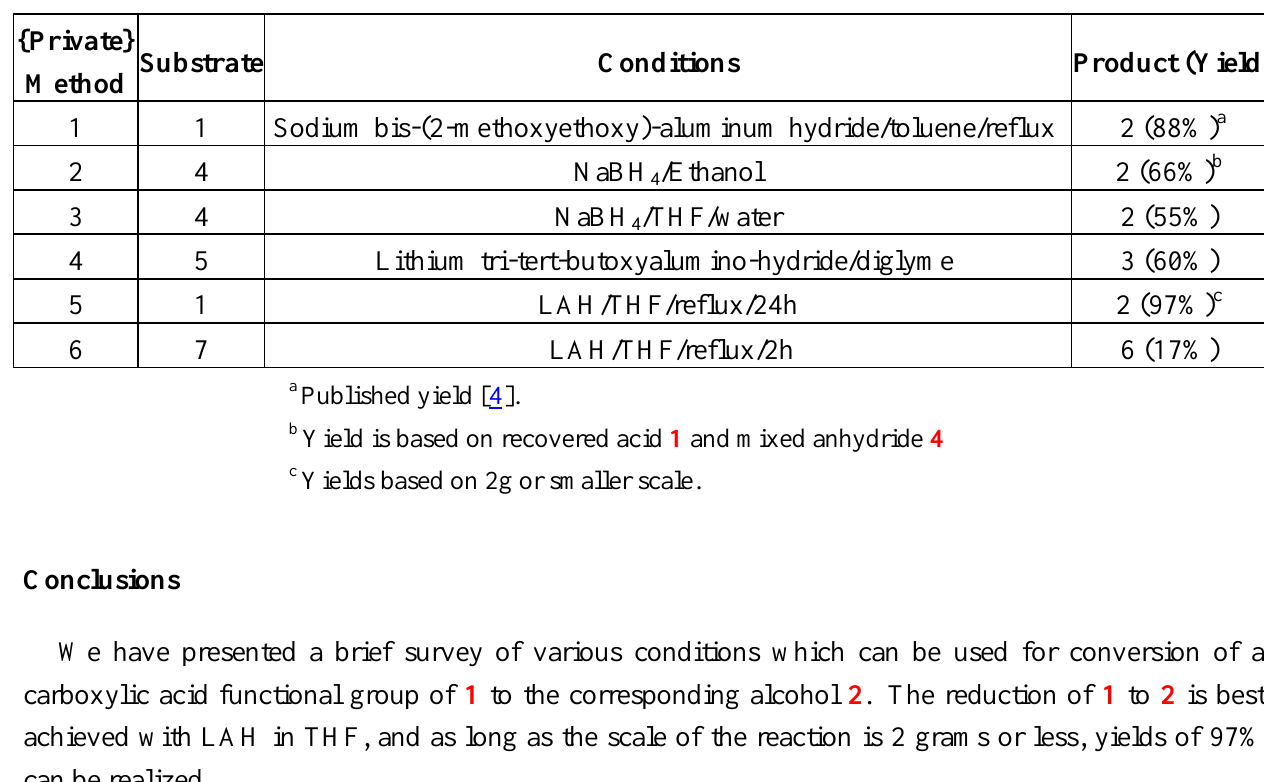
Table 1. Comparison of Methods Used to Reduce Nitroxide